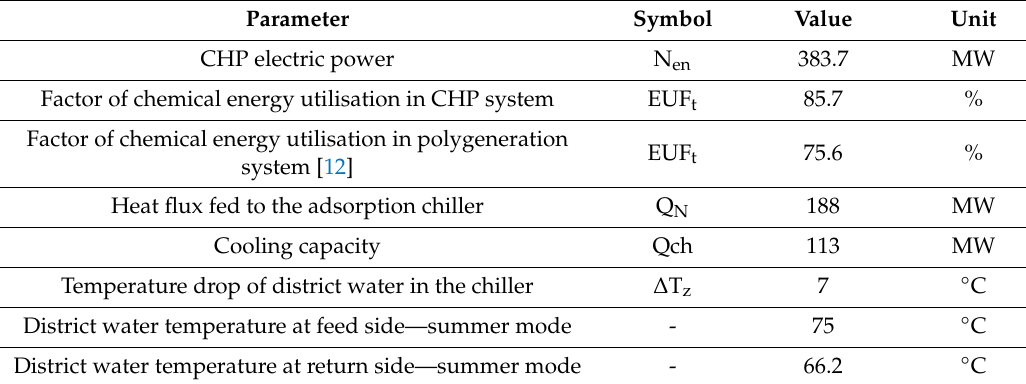
Table 4. Operating parameters of a CHP unit with an adsorption chiller.